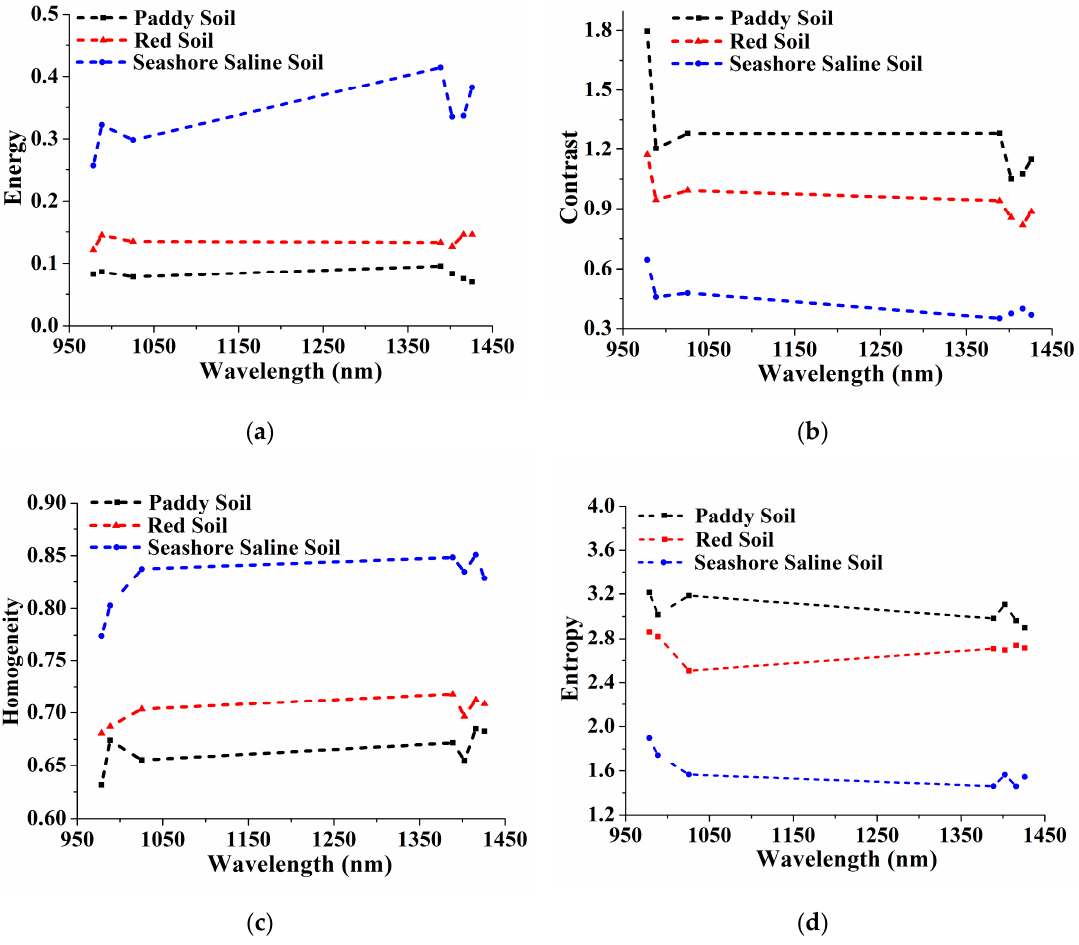
Figure 6. The mean values of ( a ) Energy, ( b ) Contrast, ( c ) Homogeneity and ( d ) Entropy of different soil types at the effective wavelengths.